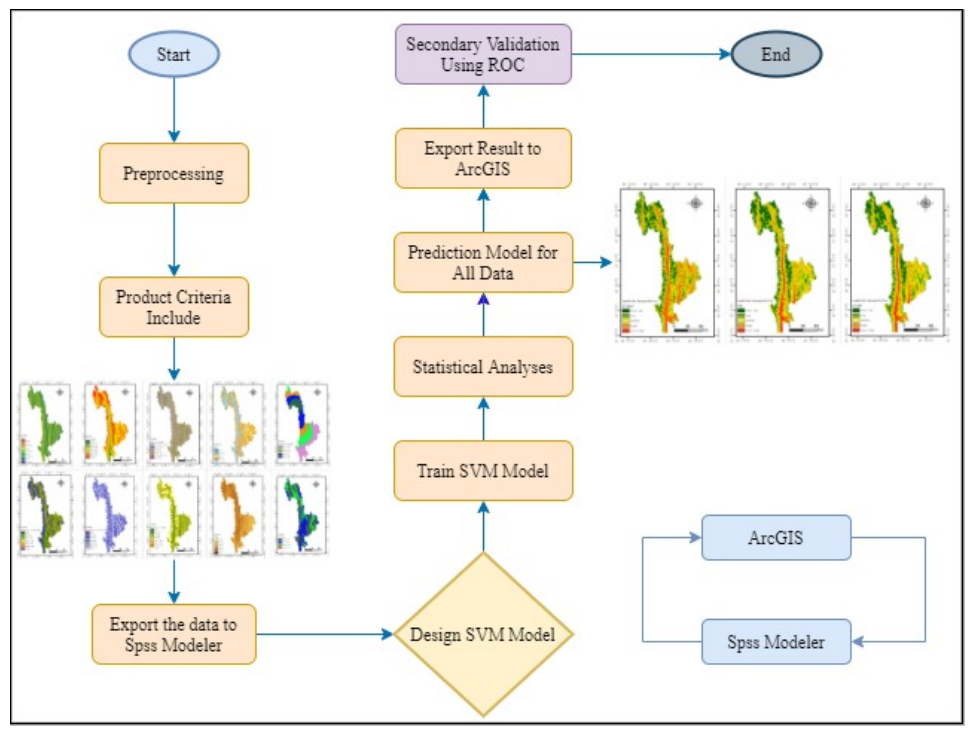
Figure 4. Graphical description of the methodological approach pursued CF-SVM-based LSM.